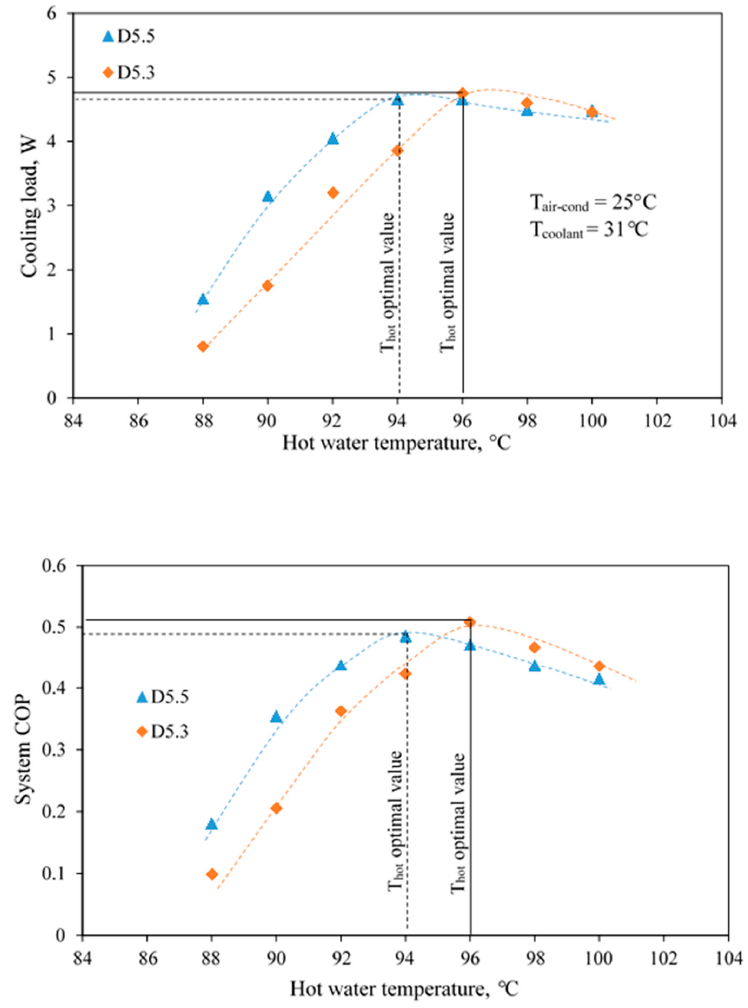
Figure 9. The cooling load and system COP against T hot influenced by primary nozzles .